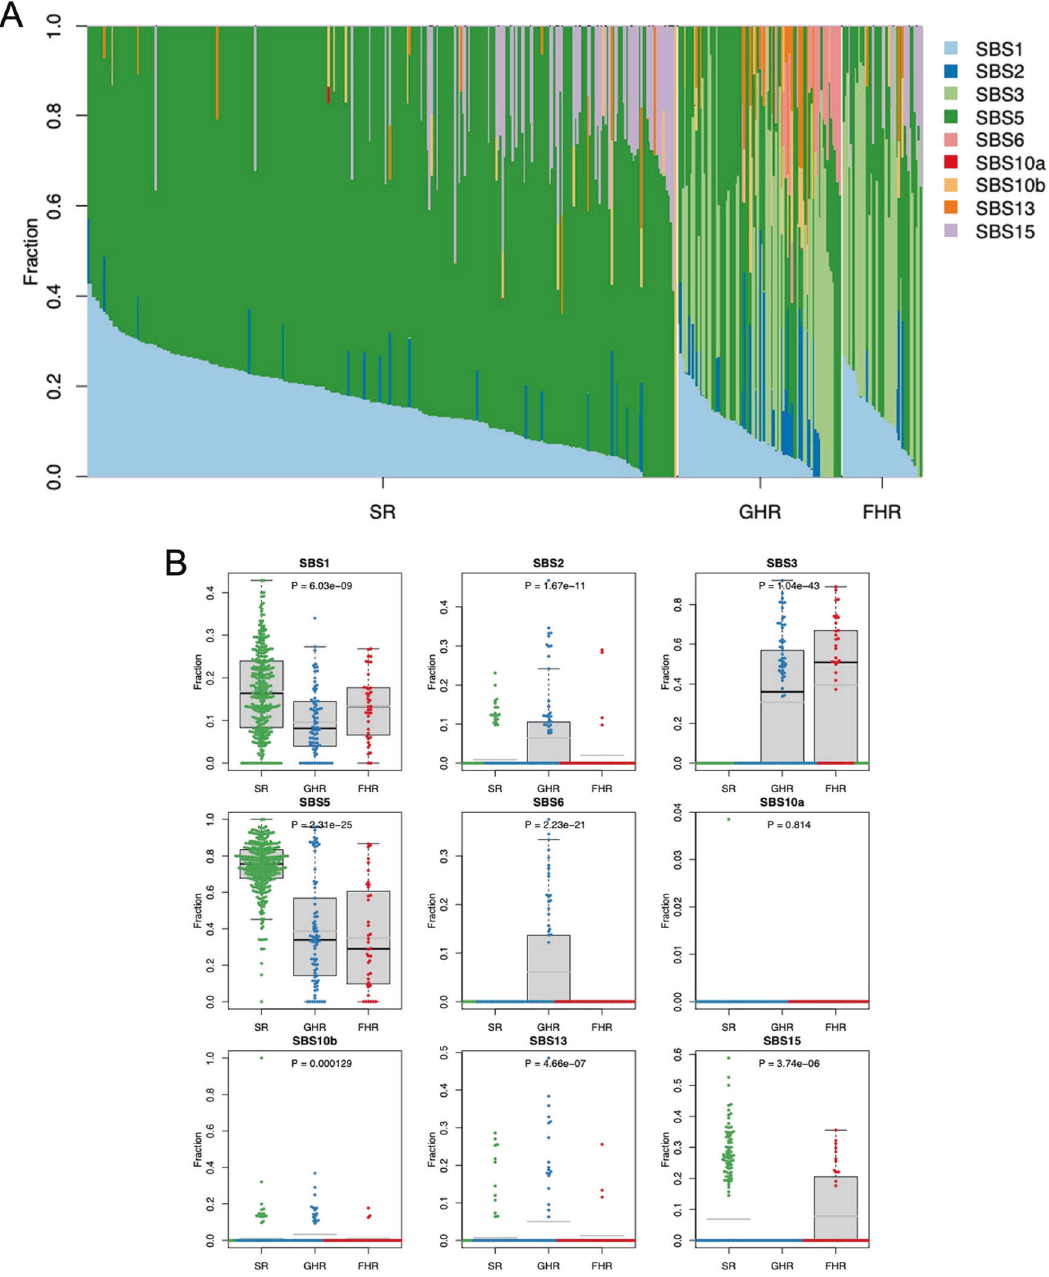
Fig. 4 Mutational Signatures for SR, GHR, and FHR groups. A For each patient, respective contributions of component MSs are indicated with different color codes. B For individual MSs, respective level of contributions among all MSs per patient are compared among the three risk groups using Kruskal-Wallis test. Here, whether the distribution of respective level of contributions in one risk group is particularly different from those of the other risk groups is tested. SBS5 is more prominent in the SR group than in the GHR and FHR groups ( p = 2.31 × 10 − 25 ), while SBS3 is more prominent in the GHR and FHR groups ( p = 1.04 × 10 − 43 ) . SBS2 ( p = 1.67 × 10 − 11 ) and SBS6 ( p = 2.23 × 10 − 21 ) are more prominent in the GHR IL-6-activated JAK/STAT3 pathway are particularly sensitive to heat STAT3 signaling pathway. The IL-6/JAK/STAT3 signaling has been shock protein 90 (Hsp90) inibitors [43], making this a potential shown to drive the proliferation, survival, invasiveness, and therapeutic target for the FHR MM patients. metastasis of cancer cells, while suppressing the antitumor immune The DEG and MS point to the importance of genomic instability, response [39]. The IL-6/JAK/STAT pathway is also important in aberrant centromere, mitosis, and abnormal DNA damage repair. myeloma and may be a good therapeutic target in myeloma [40]. We Chromosome instability has been known to be a hallmark in MM have previously shown that IL6-STAT activation may drive high-risk [44]. Centromeres and their associated kinetochores play an phenotypes via promotion of aberrant RNA editing through important role in affecting cell mitosis and therefore chromosomal upregulation of ADAR1 [41] and also upregulation of a high-risk integrity [45]. Along with the context of mitosis, centrosome phosphatase, PRL-3 [42]. Some studies showed that MM cells with an